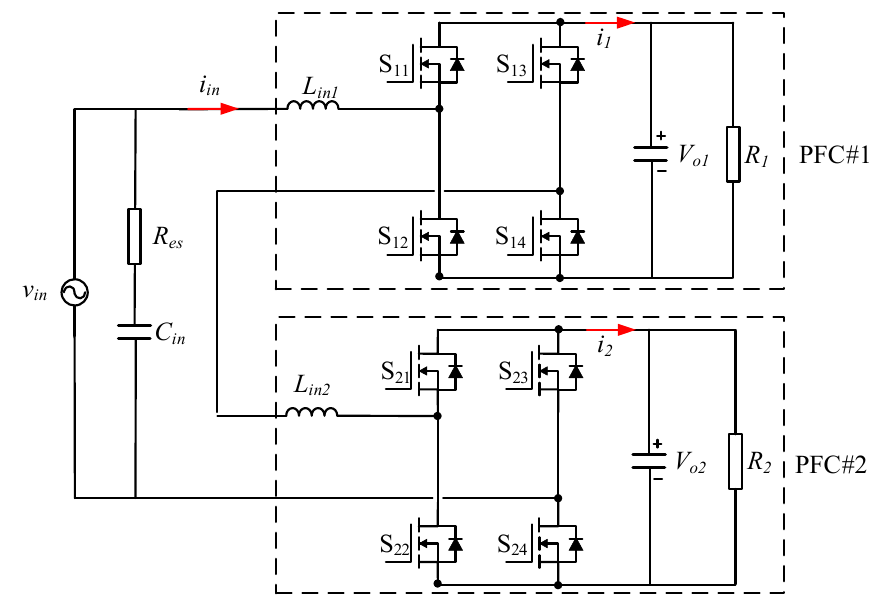
Figure 2. Schematics of two power factor correction (PFC) modules in series.